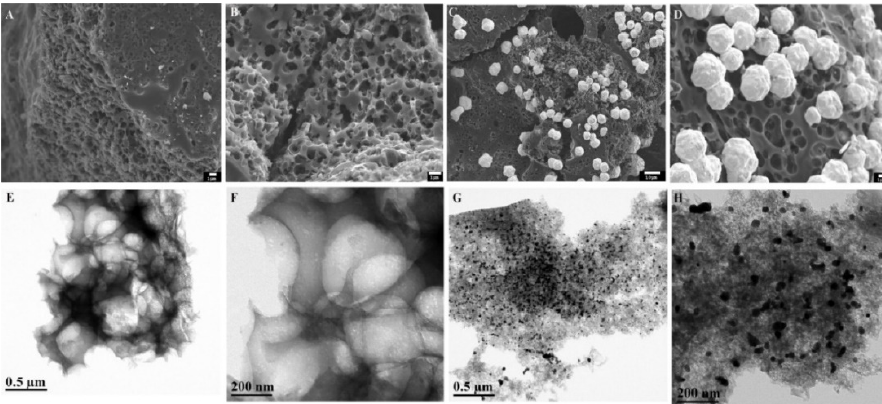
Figure 23. SEM images of BPC ( A , B ) and Au–Pt@BPC ( C , D ), TEM images of BPC ( E , F ) and Au–Pt@BPC ( G , H ) at various magnifications. Reprinted with permission from [55], ©2020 Elsevier B.V.